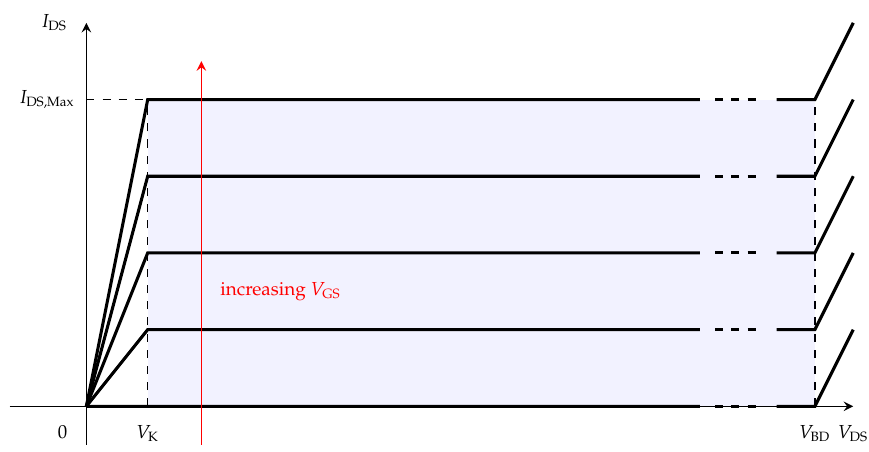
Figure 8. Output DC-IV characteristics of the simplified box model of an n-type D-mode FET.